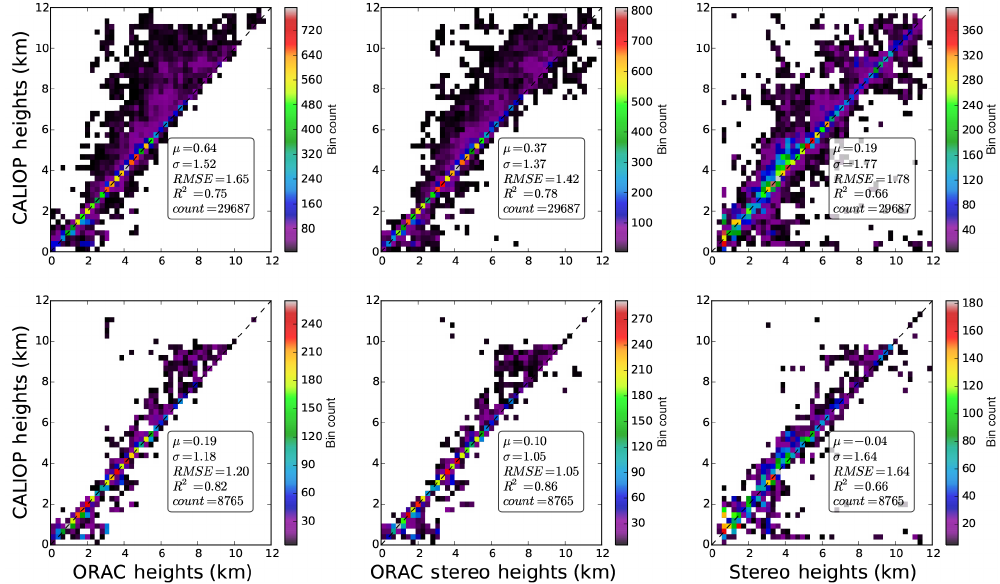
Figure 4. These plots contain the histogram analyses of CALIOP vs. ORAC, ORAC + stereo and census stereo. The upper row of histograms plots all available inter-comparison data where the phase retrieval between ORAC and ORAC + stereo agree. The bottom row of histograms plots the inter-comparison data following a screening process, where only those collocations with single-layer clouds (as determined by CALIOP) and surface ice concentrations of zero (as determined by AMSR-E) are considered. To be displayed the bin must contain more than 10